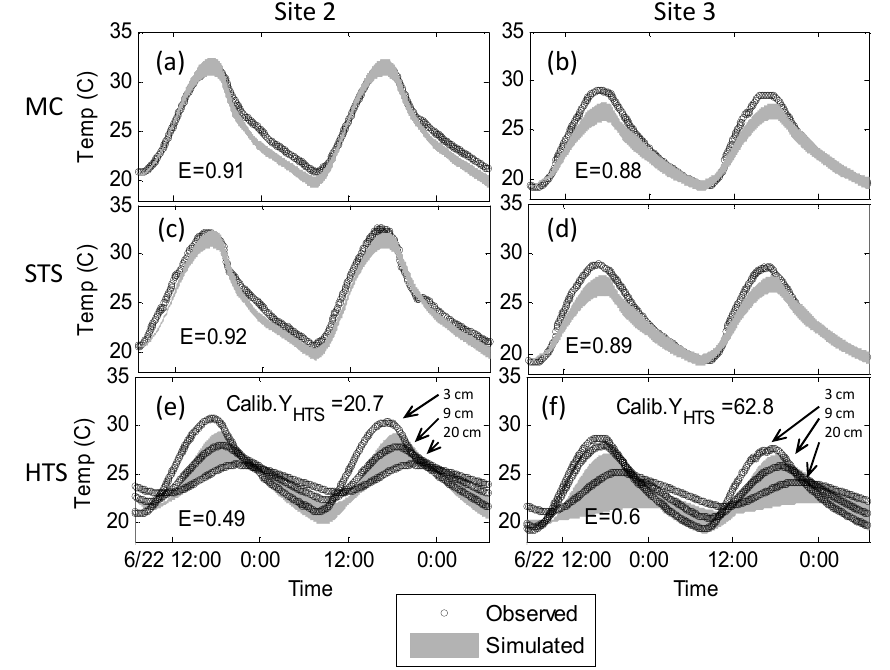
Fig. 5. Test 7 (Level 2) plots of temperature data for Site 2 and Site 3 in the main channel (MC) (a, b) , STS (c, d) , and HTS (e, f) . E , the performance at each location, is shown in each subplot. The calibrated hyporheic sediment depth ( Y HTS in cm) is shown in the HTS (e, f) with the observations at three depths labeled (3, 9 and